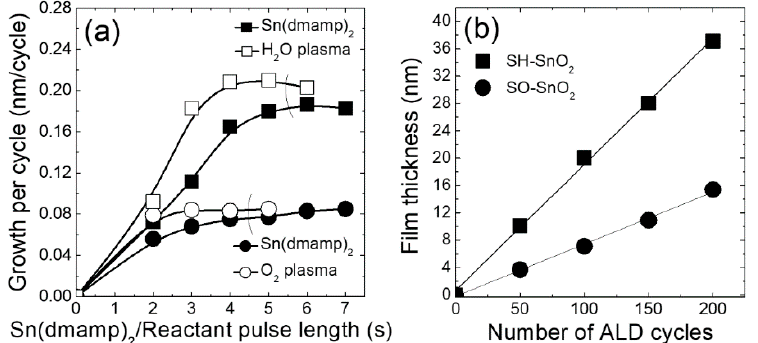
Figure 1. ( a ) Variations in the growth per cycle (GPC) of SH-SnO 2 and SO-SnO 2 plasma-enhanced atomic layer deposition (PEALD) processes at 200 °C, depending on the Sn source and reactant pulse lengths. ( b ) Change in SnO 2 thicknesses with increasing number of SH-SnO 2 and SO-SnO 2 PEALD cycles.